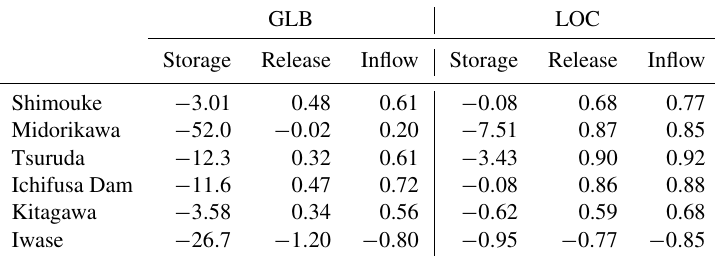
Table 8. NSE values for monthly storage, release, and inflow.